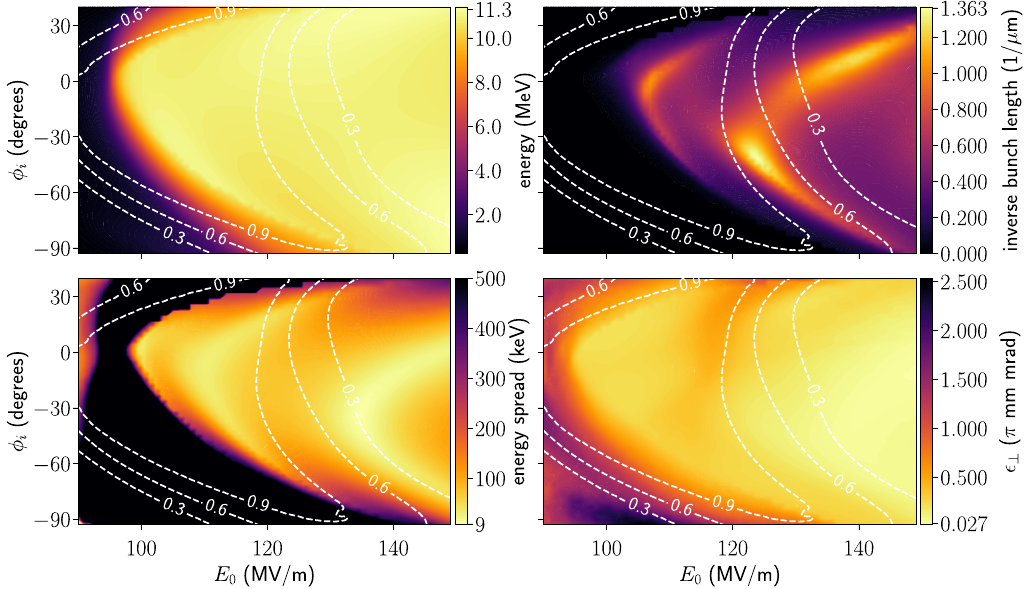
FIG. 4. Final bunch energy, inverse bunch length, energy spread, and normalized transverse emittance for the matched case, ð B 1 ; z s Þ ¼ ð 0 . 179 T ; 10 . 5 cm Þ . In each case we overlay the final bunch charge as white contour levels for 0.3, 0.6, and 0.9 charge transmission. While all final energies are approximately equal ( ∼ 11 MeV), the structure allows for the production of widely-tunable electron beams.